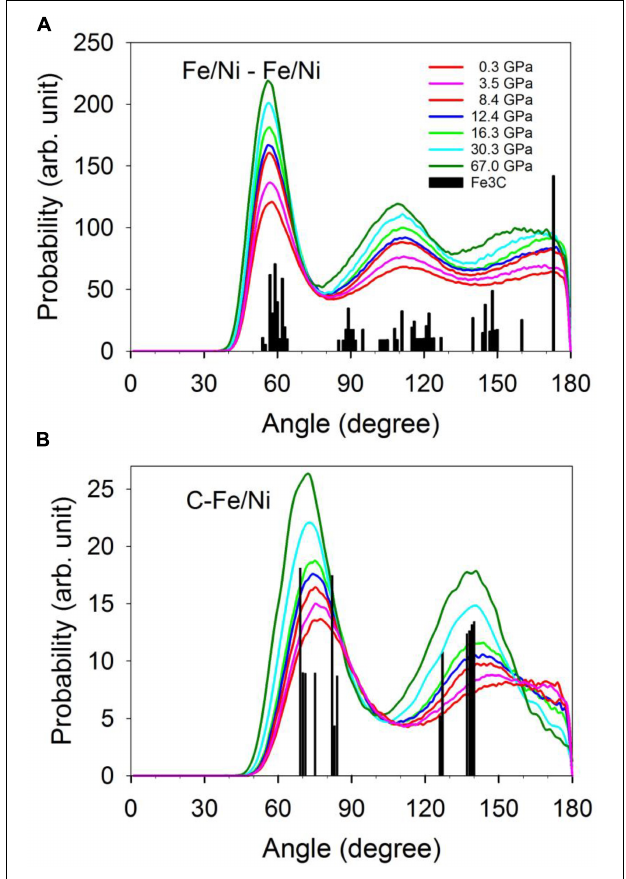
FIGURE 4 | Distribution of the angles between the central atom with two coordinated Fe/Ni. (A) The central atom is Fe/Ni. (B) The central atom is C. The vertical bars are the distribution of the angles of the Fe 3 C phase.